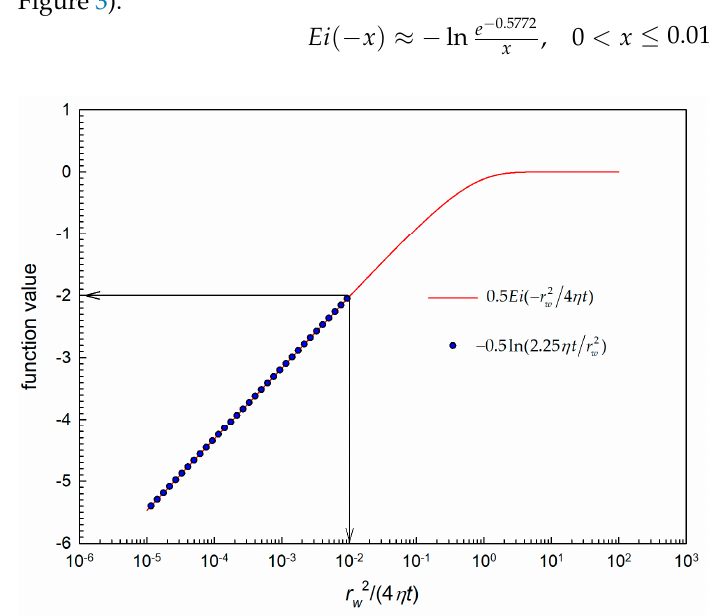
Figure 3. Different function curves representing the physical constraint of skin